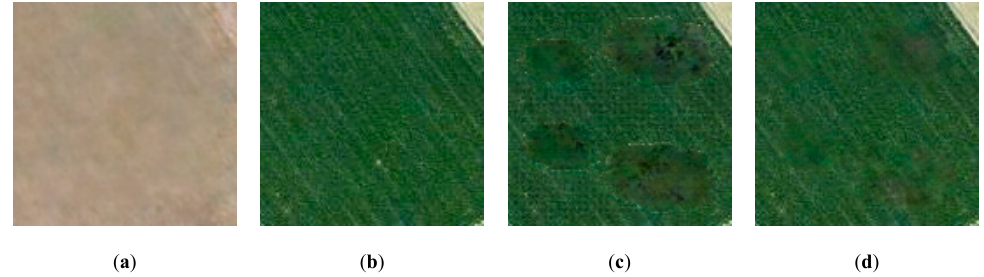
Figure 10. Result of the model without perceptual loss when simulation network fails to work. ( a ) Output of the simulation network; ( b ) ground truth ( c ) model without perceptual loss and ( d ) original model.